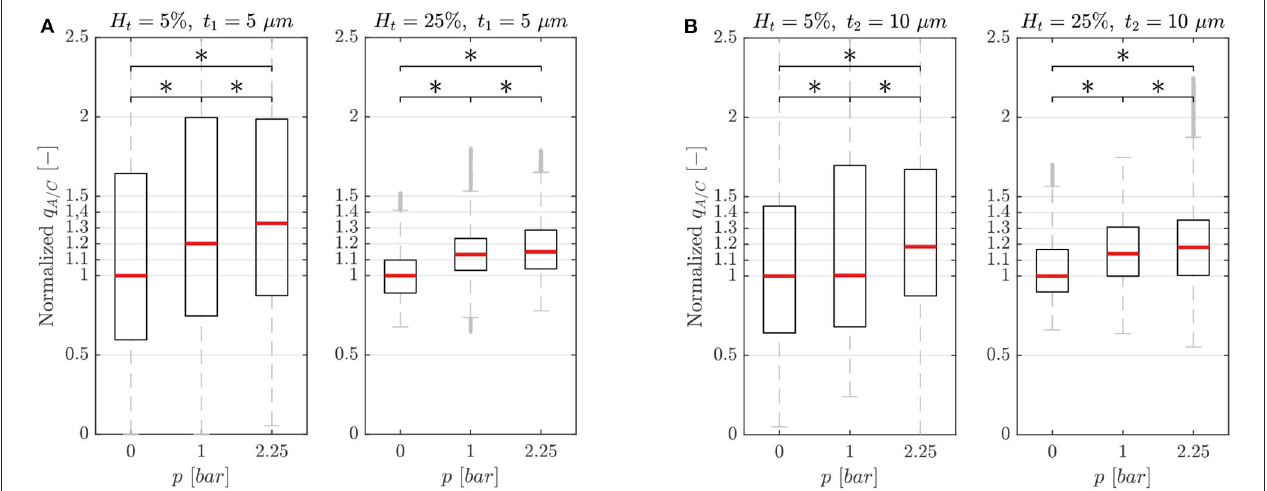
FIGURE 4 | Characterization results. Characterization results for the single-mesh network with membrane thickness t 1 sampled from the ROIs illustrated in Figure 1 and show the RBC flux ratio between the activated and control branch in function of the hematocrit H t and pressure p in the pressure chamber ( ∗ p -value < 0.05, boxes indicate the 25th and 75th percentiles; red lines: median values; gray subplot have been normalized with respect to the median value of the respective RBC flux ratio at p